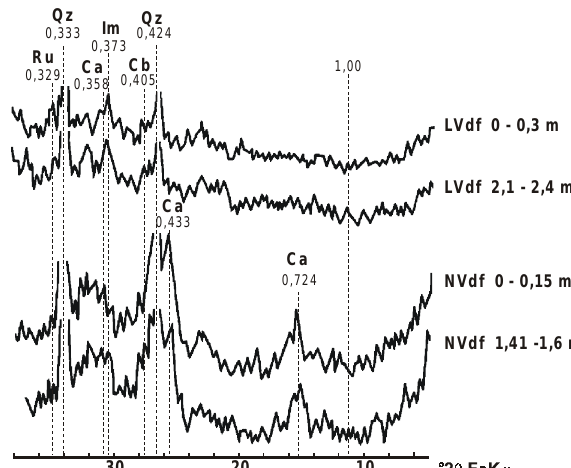
Figura 1. Difratogramas de raios-X da fração areia (espaçamento “d” em nm), em duas profundida- des, do Latossolo Vermelho distroférrico típi- co (LVdf) e do Nitossolo Vermelho distroférrico típico (NVdf). Qz = quartzo, Ca = caulinita, Cb = cristobalita, Im = ilmenita, Ru = rutilo.